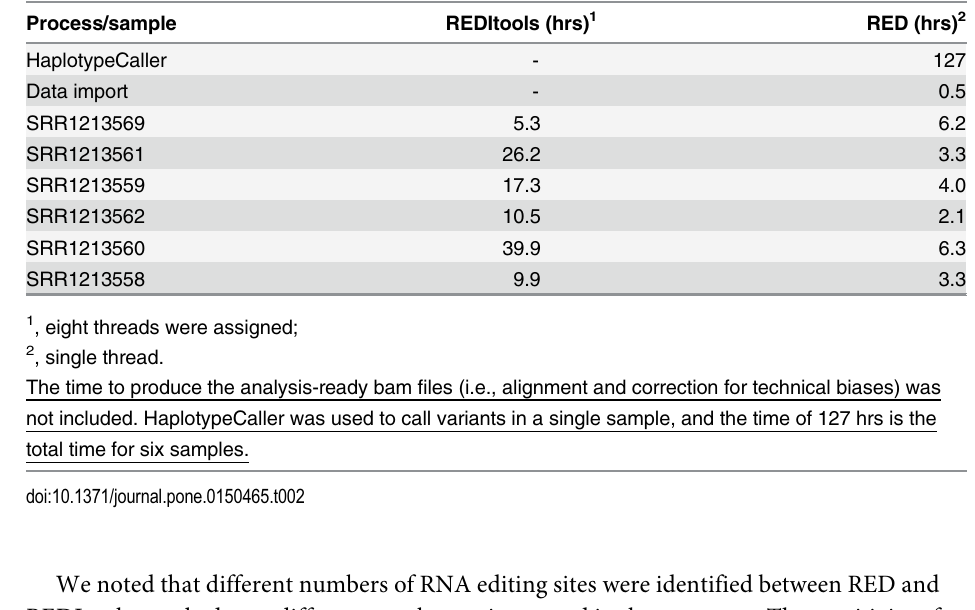
Table 2. Computation cost in REDItools and